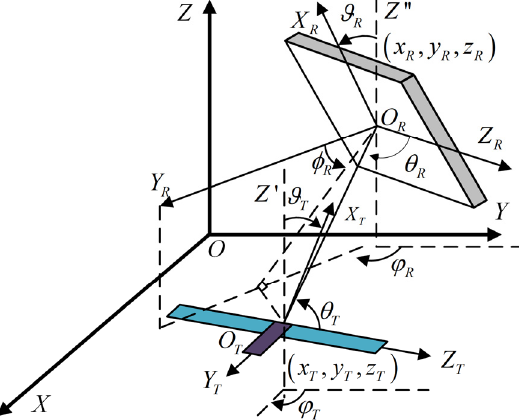
Figure 3. The Cartesian coordinate system for characterization of tag antenna and reader antenna.